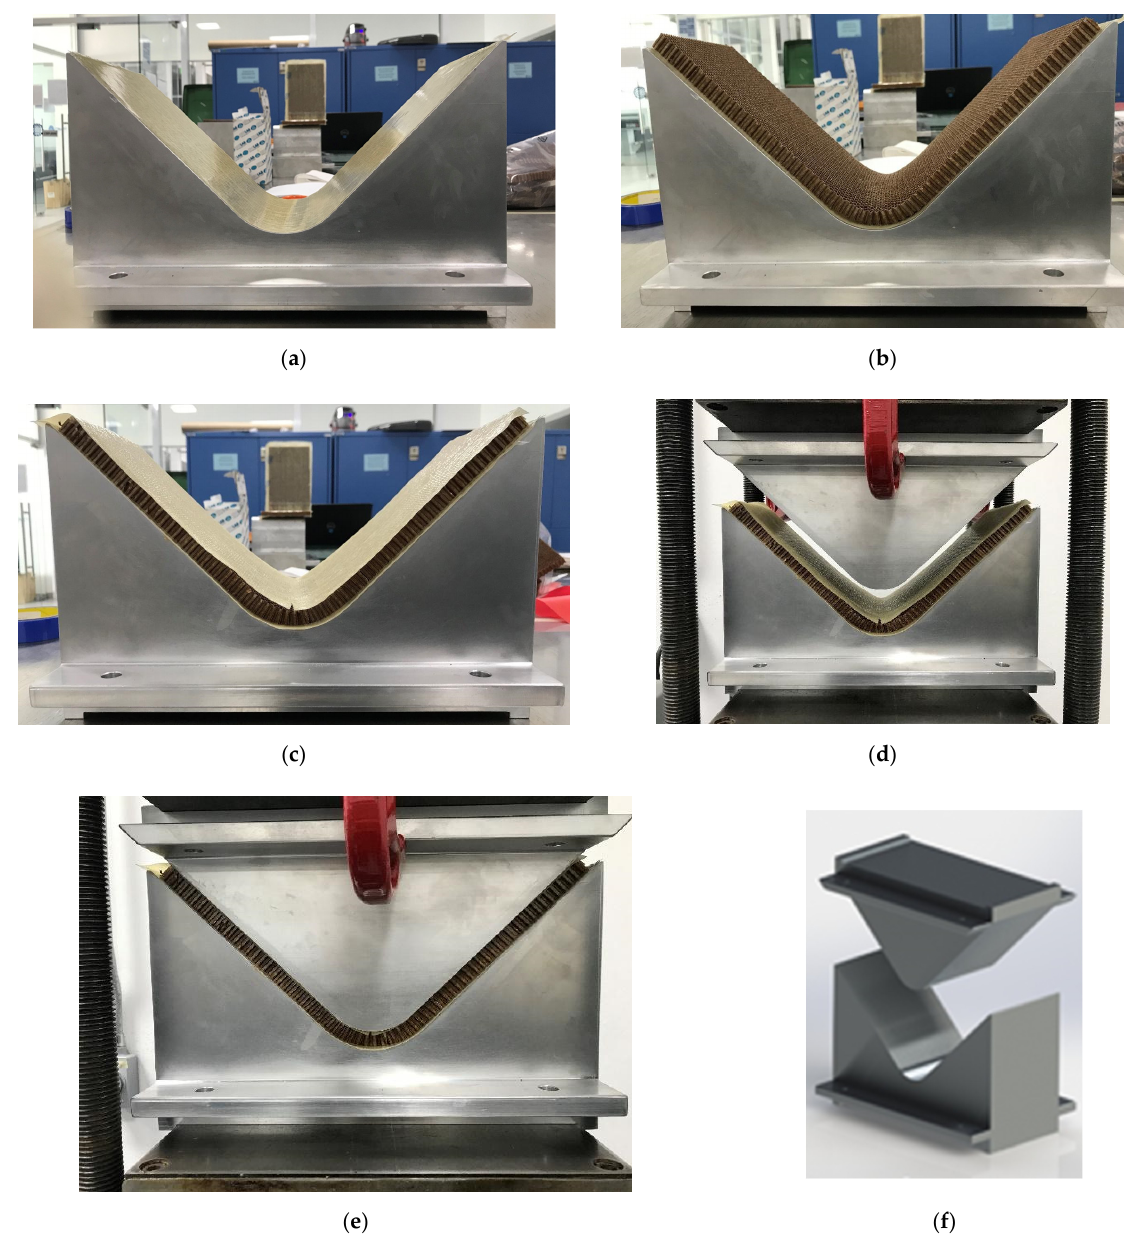
Figure 3. Schematic representation of the V ‐ shaped mold to produce composite sandwich panels: ( a ) Two layers of GF prepreg (step two), ( b ) HC placement (step three), ( c ) complete sandwich structure (step three), ( d ) preheated process (step four), ( e ) manufacturing of V ‐ shaped panel (step five), and ( f ) digital rendering of the V ‐ shaped mold.